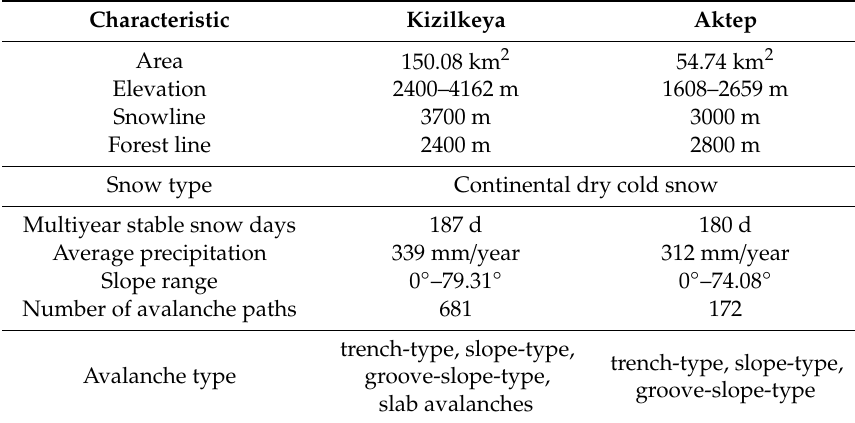
Figure 1. Schematic diagram of the study area. ( a ) Avalanche blocked the national highway G217; ( b ) avalanches threaten the safety of human life and appendages. Table 1. Statistics of geographical attributes statistics for the implementation